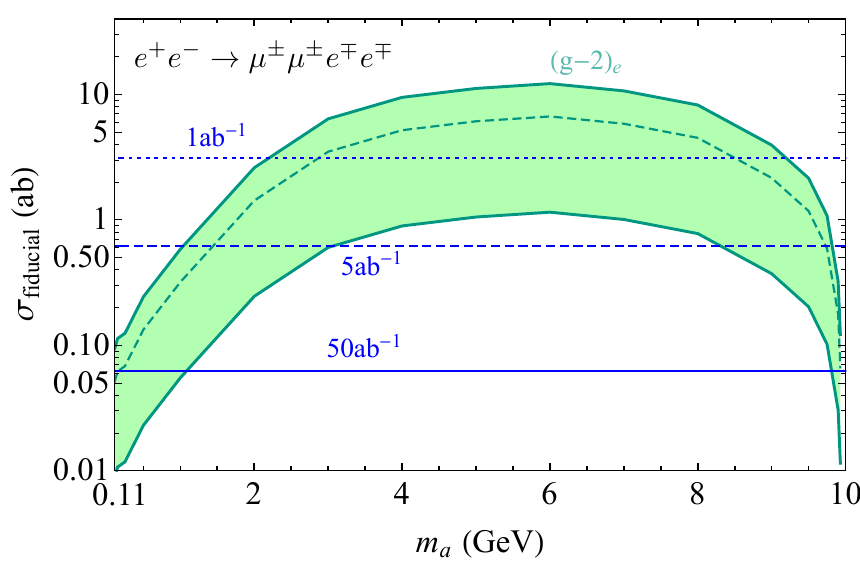
Figure 4 . The (cid:12)ducial production cross section of e + e (cid:0) ! (cid:22) (cid:6) (cid:22) (cid:6) e (cid:7) e (cid:7) as a function of m a . Here, ( y A ) e(cid:22) and m a are varied, while ( y V ) e(cid:22) = 0 is (cid:12)xed. The electron g (cid:0) 2 discrepancy is explained within the 2 (cid:27) level in the green band with the central value shown by the green dashed line. The horizontal dotted, dashed, and solid blue lines represent the expected sensitivity of the Belle II experiment with the integrated luminosity of 1, 5, and 50 ab (cid:0) 1 , respectively. of e + e (cid:0) ! (cid:22) (cid:6) e (cid:7) a for a heavier ALP is suppressed both by the phase space and by the kinematical